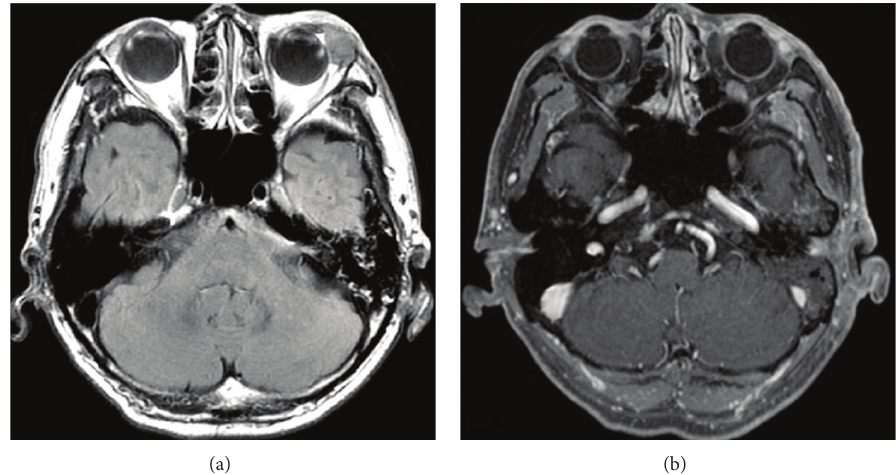
Figure 2: Pretreatment (a) and posttreatment (b) of MRI findings of the left lacrimal gland. After combination therapy, the tumor in the left lacrimal gland was not